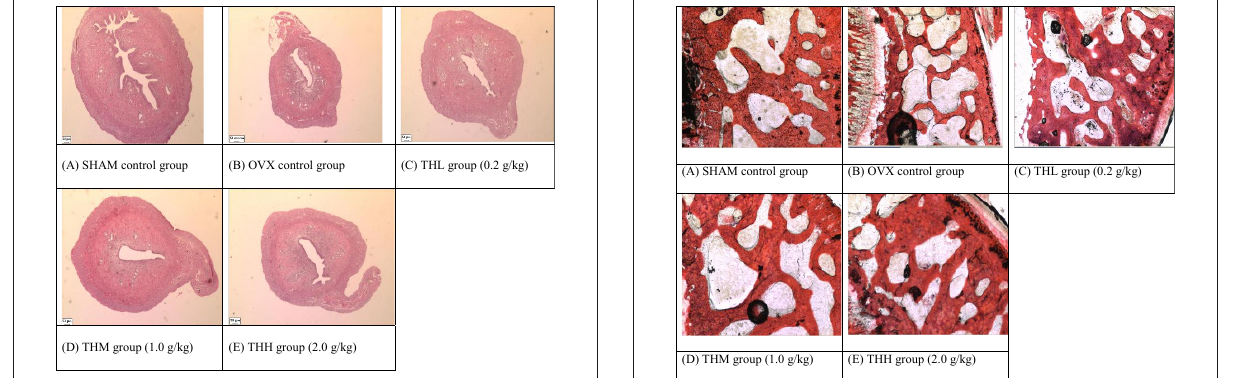
Figure 3 Effects of Tualang honey on trabecular thickness of tibia bone . Histopathological examination (HPE) indicated that Tualang honey is able to restore the trabecular thickness in tibia bone of ovariectomised rats. All pictures are stained with H&E and examined under ×20 magnification: SHAM = Sham-operated control rats, OVX = ovariectomised non-honey treated control rats, THL = Tualang Honey, low dose, THM = Tualang Honey, medium dose, THH = Tualang Honey, high